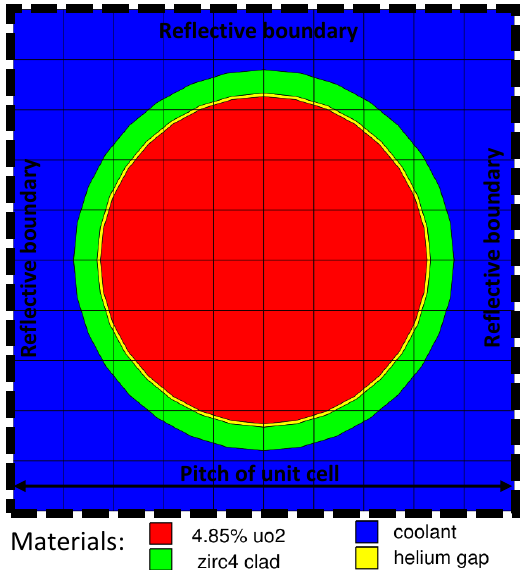
Figure 2. TRITON model model for Exercise I-1b Pin